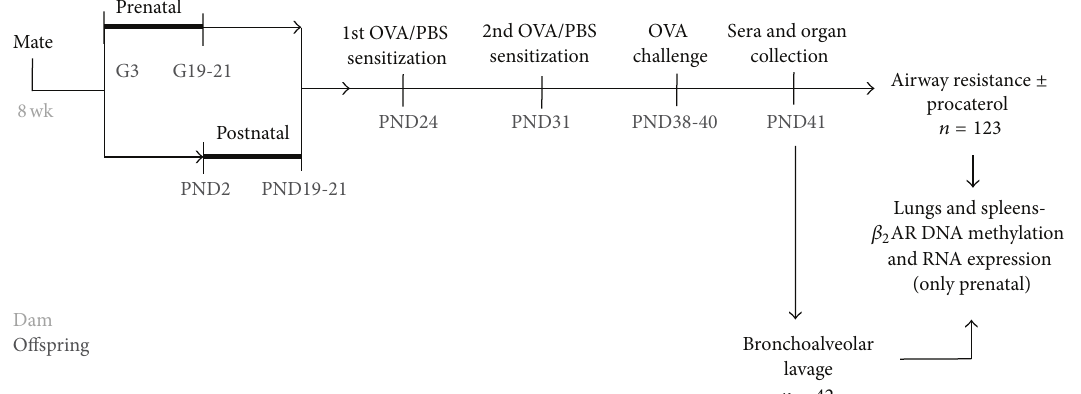
Figure 1: Algorithm of experimental design. Mice were exposed to PAH or normal air either on GD 3 to 19–21 or PND 2 to 19–21. Offspring weresensitizedtoeitherOVAorPBSonPND24andthenagainonPND31.ThemicewereOVAchallengedonPNDs38–40.Airwayresistance was measured and biospecimens were collected on PND 41.